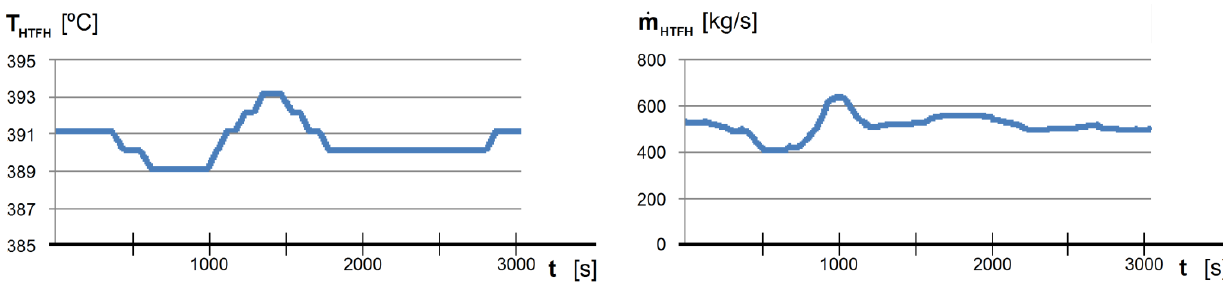
Figure 13. Variation of the perturbations considered when calculating the error represented in Figure 12.